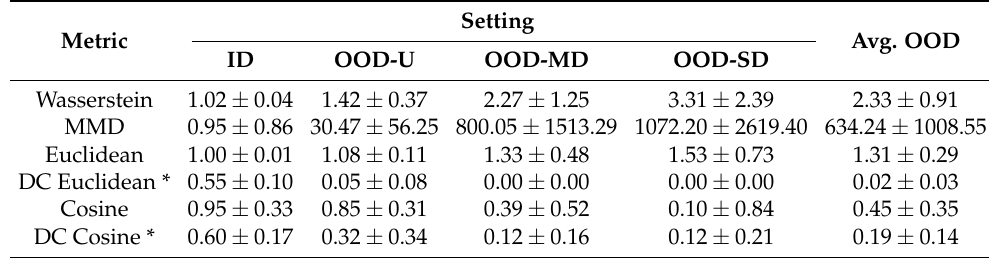
Table 3. Comparison of metrics over all four domain generalization settings based on the TSFEL feature representations. For each setting, values were averaged over every test set. All metrics are ratios except the ones with (*).